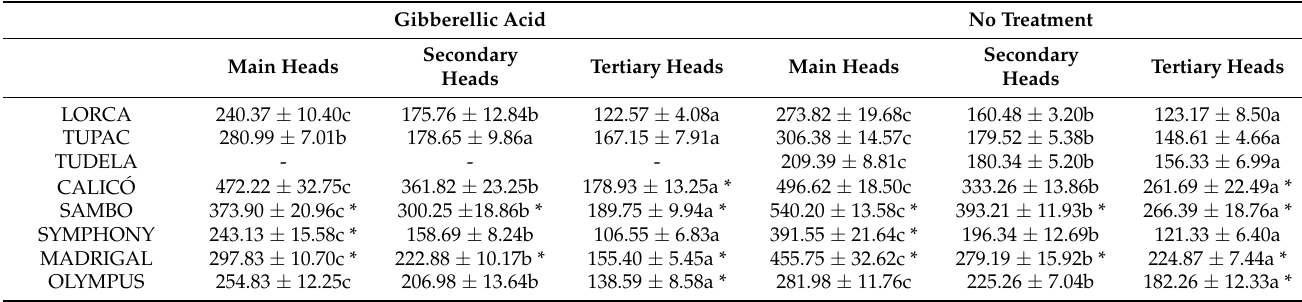
Table 1. Average flower head weight (g) of globe artichoke cultivars influenced by flower head order (main, secondary, and tertiary heads) and treatment (gibberellic acid or no treatment) 1